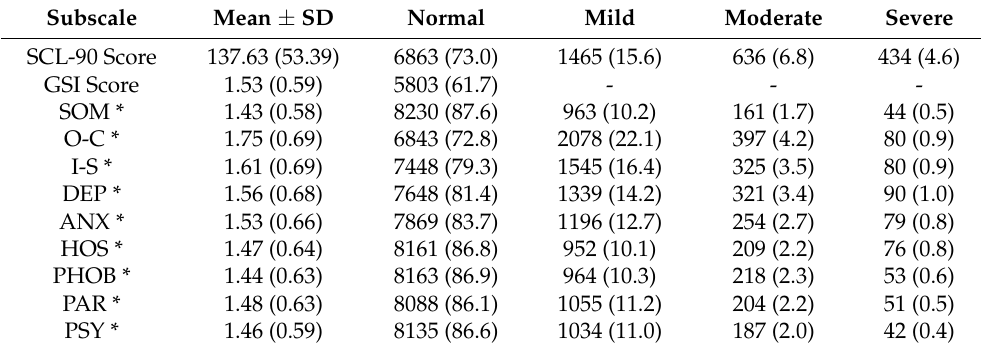
Table 2. Prevalence of different levels of mental health problems, n (%). Subscale Mean ±